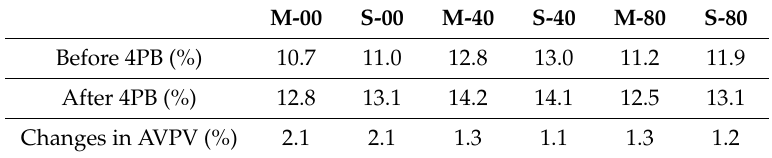
Table 8. AVPV of the concrete specimens measured before 4PB, after 4PB and the changes in